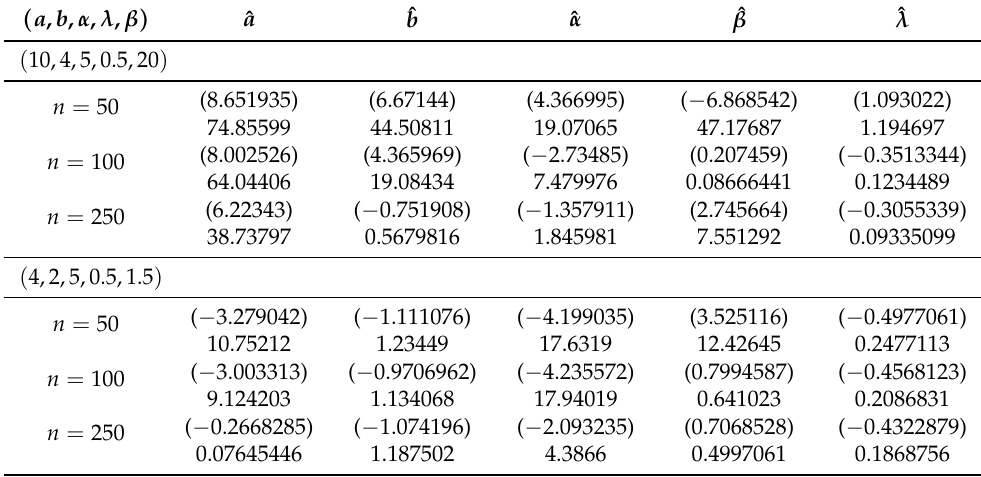
Table 2. Bias in parenthesis and MSEs for different sample sizes in the context of the KPL